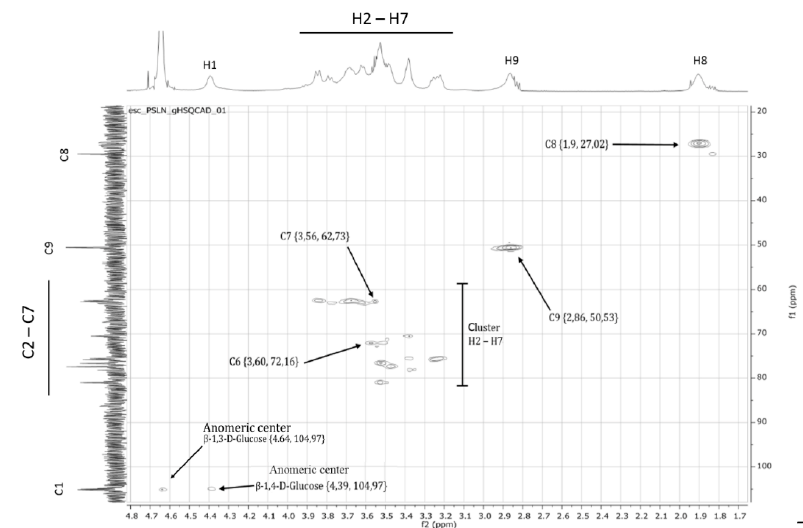
Figure 2. Relevant details of the 1 H- 13 C-HSQC-NMR spectrum of γ -PSL. Additional signals of γ -PSL, in comparison to unsubstituted lichenan, are marked by